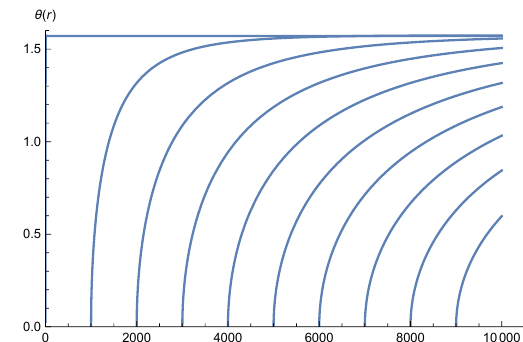
Figure 7. Plot of θ ( r ) as a function of r, for various values of θ 0 , in the case of the D 0 brane, with R = 1 , r UV = 10 4 . As is clear from the plot, as θ 0 increases, r 0 decreases. Also, as r → ∞ , θ asymptotes to π/ 2